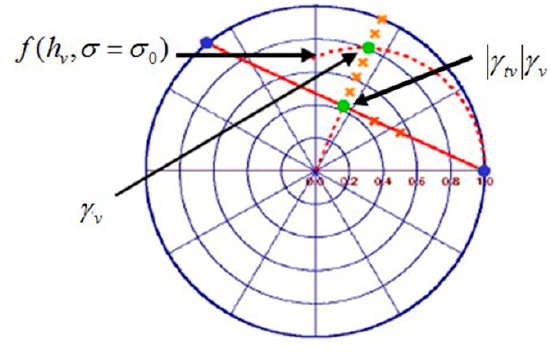
σσ= σσ= [10]. [10]. Figure 7. Geometrical representation of the RVoG+VTD inversion using σ = σ 0